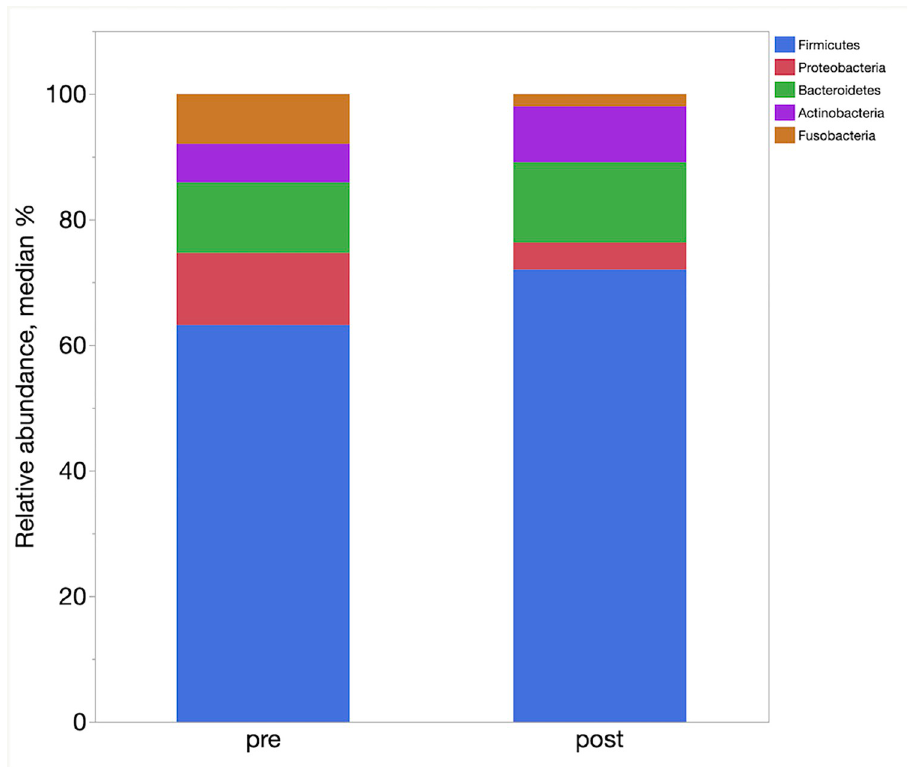
Fig 6. Relative abundances of the main bacterial phyla enriched between the pre and one-week post FMT